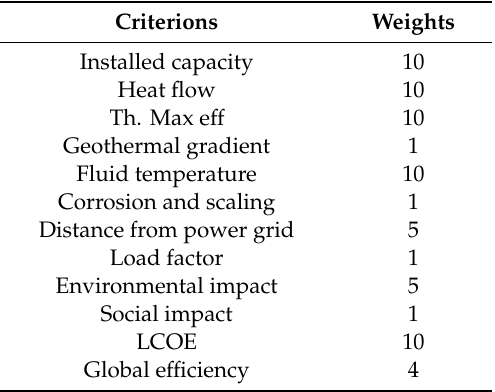
Table 3. Electricity assigned